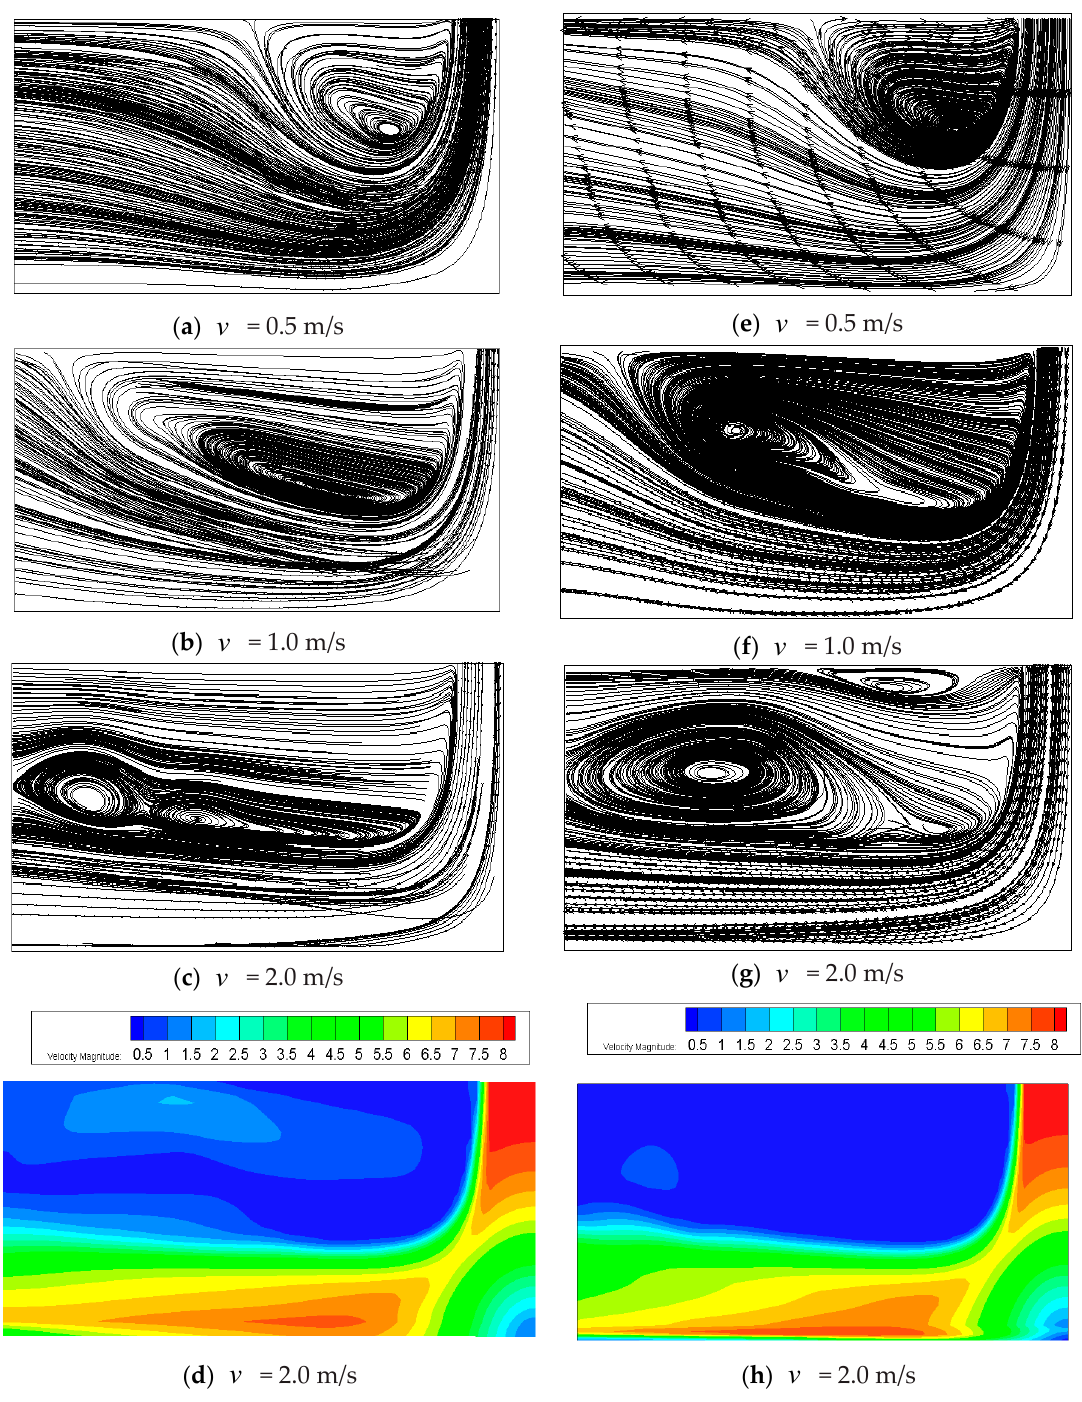
Figure 7. Streamlines in Y-Z symmetry plane for the plate fin heat sink with (left: ( a – c )) and without (right: ( e – g )) elliptic bottom profiles in the condition of s = 10% L for different velocities v = 0.5, 1.0, and 2.0 m/s; velocity contours in Y-Z symmetry plane for the plate fin heat sink with (left: ( d )) and without (right: ( h )) elliptic bottom profiles in the condition of s = 10% L for v = 2.0 m/s.